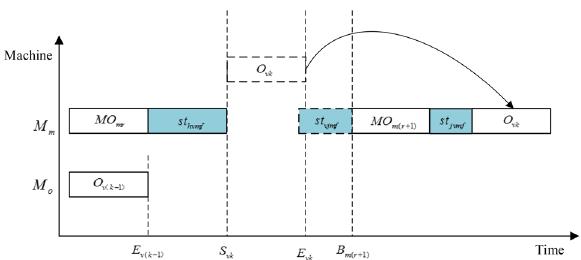
Figure 5. The decoding diagram of operation O vk when E vk > B m ( r + 1 ) − st vjmf